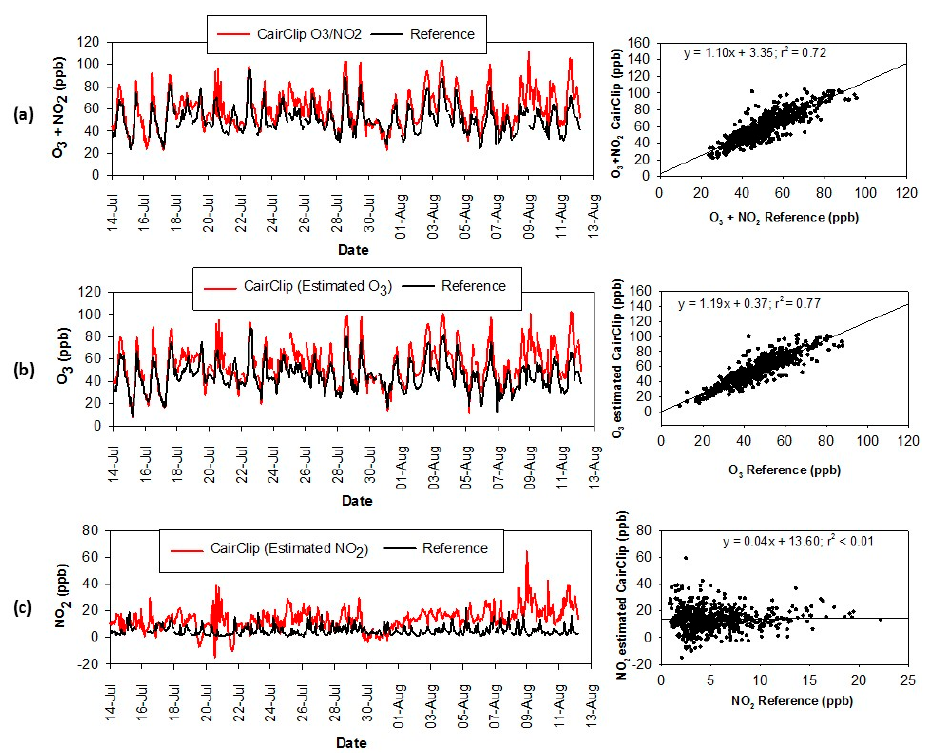
Figure 5. Time series and scatter plots of hourly average reference measurements during the Denver campaign compared to the ( a ) CairClip O 3 /NO 2 sensor; ( b ) estimated O 3 values for the CairClip O 3 /NO 2 sensor; and ( c ) estimated NO 2 values for the CairClip O 3 /NO 2 sensor.